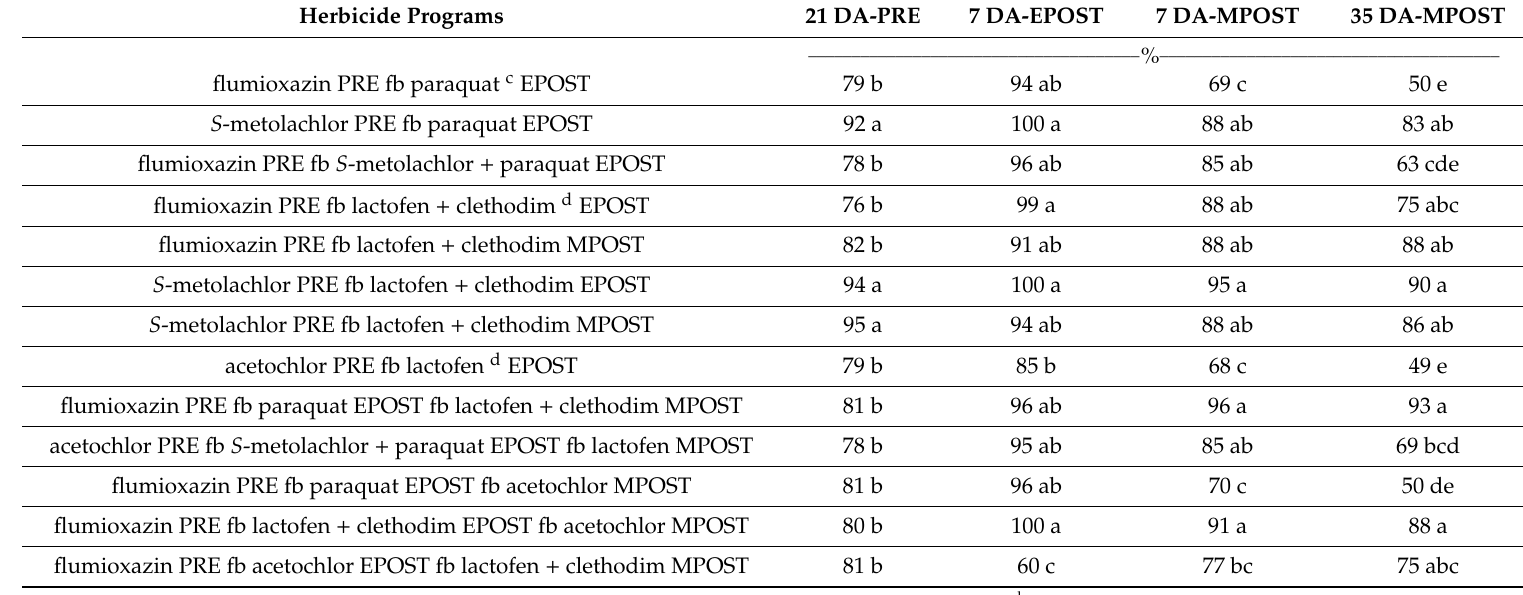
Table 3. Control of barnyardgrass 21 DA-PRE, 7 DA-EPOST b , and 7 and 35 DA-MPOST b treatments in Weed Control Study at Stoneville, MS averaged over 2017 and 2018 a